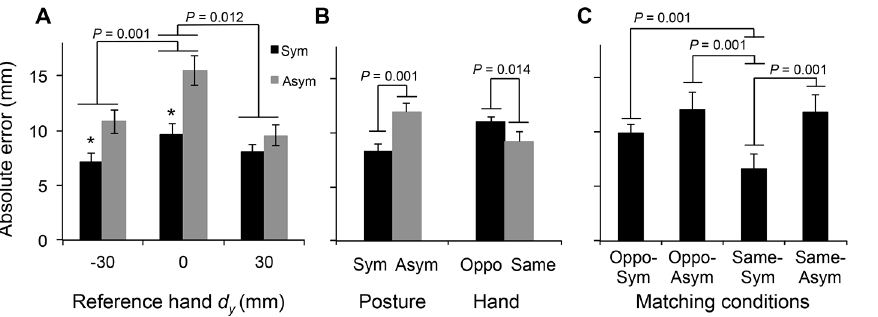
Figure 4. Absolute error: average data. Absolute errors were compared across reference hand d y s, postures, hands, and matching conditions. Panel A shows average absolute error for symmetric and asymmetric conditions (black and gray bars, respectively) across reference hand d y s. Panel B, left, shows average absolute error for symmetric and asymmetric conditions (black and gray bars, respectively) as a function of hand posture (Sym, Asym: Symmetric and Asymmetric conditions, respectively). Panel B, right, shows average absolute error when reference and test hand differed or were the same (Oppo, Same: Opposite and Same conditions, respectively). Panel C shows absolute error averaged for each condition. For all panels, absolute errors were averaged across all subjects within the given comparisons groups ( 6 SE). The asterisks denote significant difference ( p , 0.05) between the symmetric and asymmetric conditions.